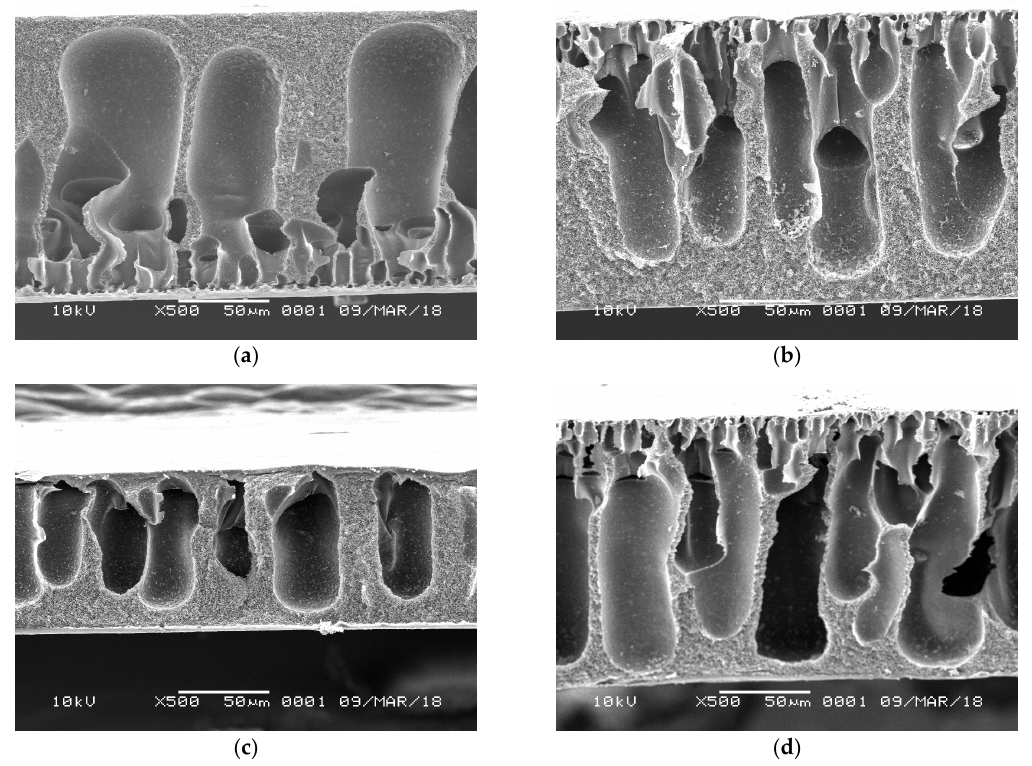
Figure 7. Cross-Section SEM images (500 × magnification): ( a ) cellulose acetate (CA) pristine membrane made of dimethylformamide (DMF) solvent, ( b ) CA mixed matrix membranes (CA MMM) with 1 wt% Moringa seeds powder made of DMF solvent, ( c ) CA pristine membrane made of DMAc solvent, and ( d ) CA MMM with 1 wt% Moringa seeds powder made of DMAc solvent.